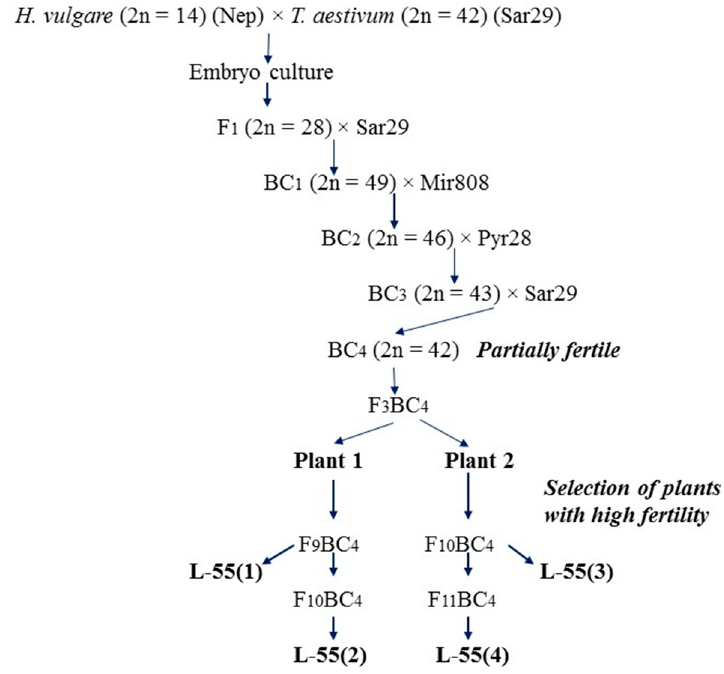
Figure 2. The scheme for the production of alloplasmic recombinant lines ( H. vulgare )- T. aestivum lines L-55(1), L-55(2), L-55(3) and L-55(4). (Nep: barley variety Nepolegaushii; varieties of bread wheat: Sar29: Saratovskaya 29; Mir808: Mironovskaya 808; Pyr28: Pyrotrix 28. Table 1. Origin of alloplasmic recombinant ( H. vulgare )- T. aestivum lines and control genotypes. ( H.v .: H. vulgare ; In all cases, the source plants for the formation of alloplasmic recombinant lines were selected among self-fertile plants using the 18S/5S mt repeat as a marker for the distinction of alloplasmic lines into lines with cytonuclear incompatibility and compatibility [27,28]. Each group included lines with a close origin but that differed in the incompleteness/com- pleteness of their cytonuclear compatibility (Table 1).